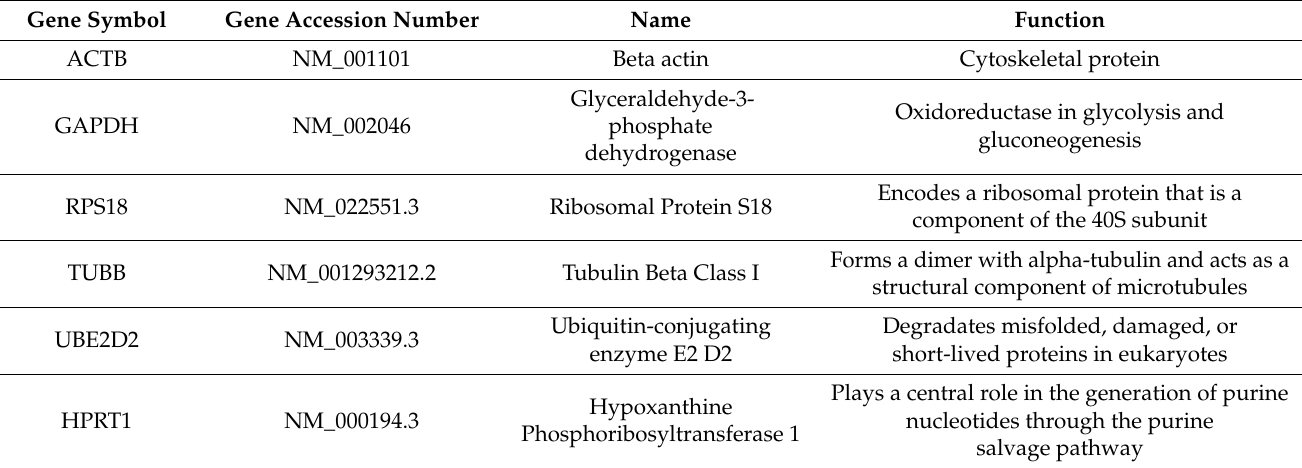
Table 1. List of candidate reference genes evaluated in this study. Function information based on data